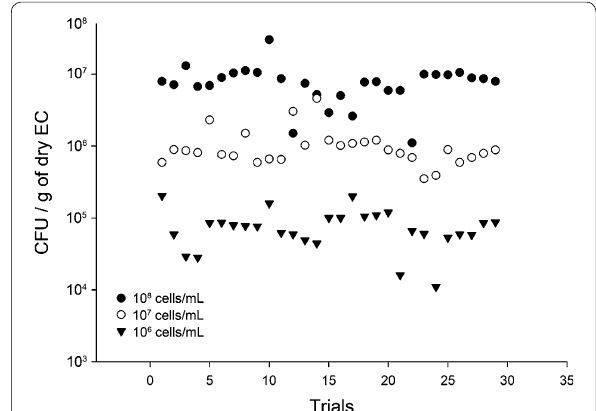
Fig. 2 Colony forming unit (CFU) assay of bacteria YS11 that was immobilized into expanded clay using different bacterial concentrations. Expanded clay was submerged into PBS containing various bacterial concentrations (1.0